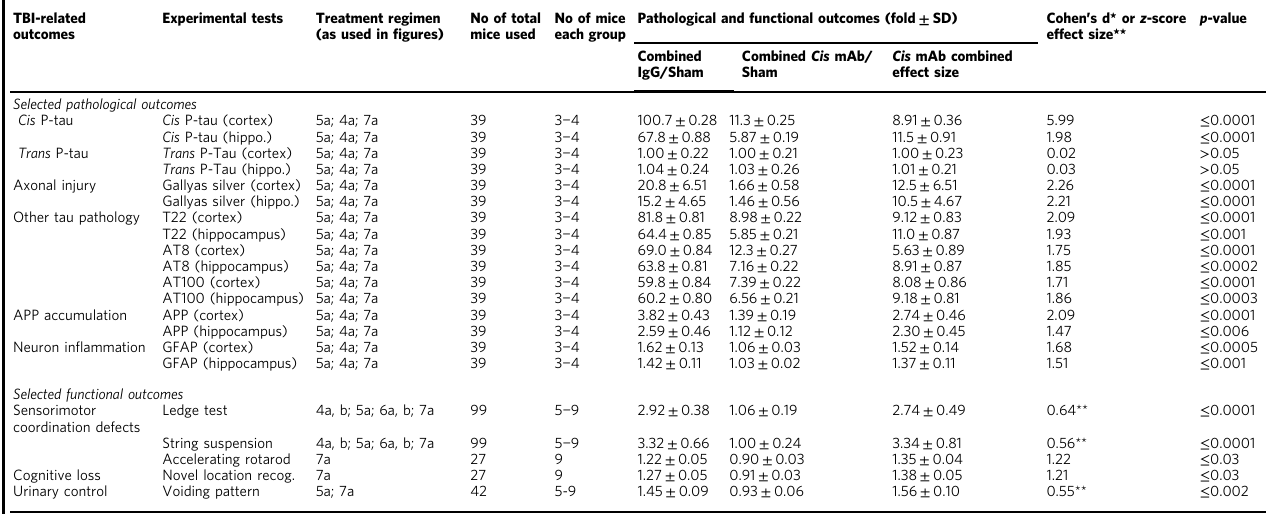
Table 1 Combined therapeutic outcomes of cis mAb treatments in ssTBI mice or rmTBI mice regimens TBI-related Experimental tests Treatment regimen outcomes (as used in fi gures)